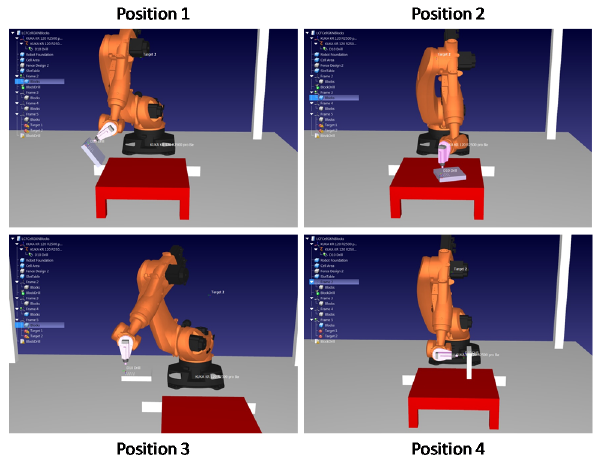
Figure 20. Robot configurations tested.